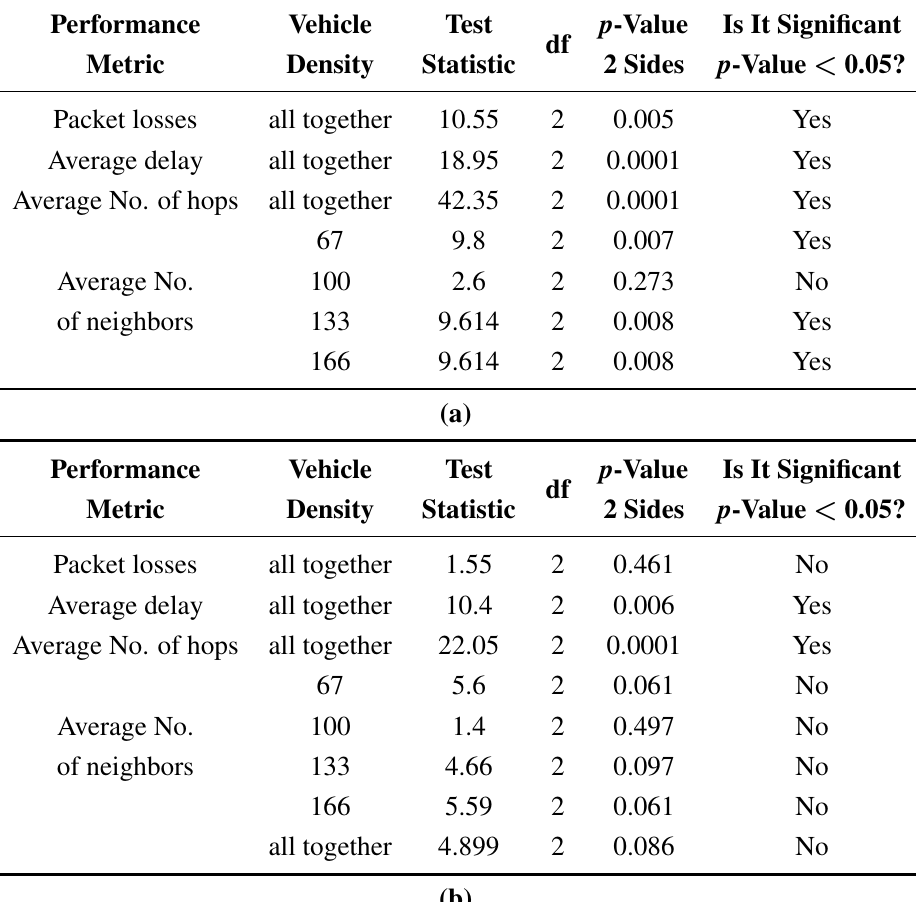
Table 3. p -Values from the Friedman test to determine the effect of the building attenuation